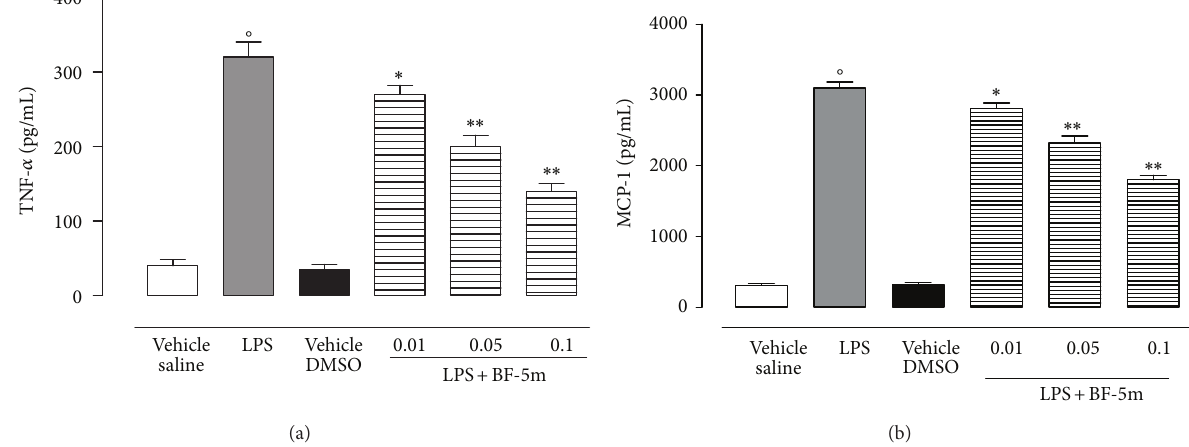
Figure 5: Ocular levels of tumor necrosis factor alpha (TNF- 𝛼 ) and monocyte chemoattractant protein-1 (MCP-1) within the tissue of rats with EIU, evaluated 24h after the administration of vehicle (saline), vehicle (DMSO), LPS (200 𝜇 g/s.c.), or LPS+BF-5m (0.01; 0.05; 0.1 𝜇 M/rat) into the vitreous. The values are expressed as mean ± SEM of 𝑛 = 6 observations for each group. ∗ 𝑃 < 0.05 and ∗∗ 𝑃 < 0.01 versus LPS-treated rats; ∘ 𝑃 < 0.01 versus vehicle saline